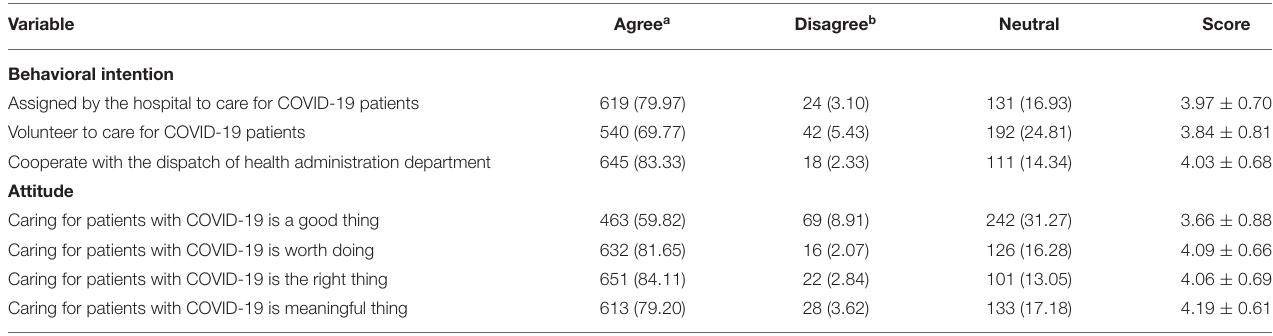
TABLE 3 | Respondents’ behavioral intentions and attitude toward caring for COVID-19 patients.